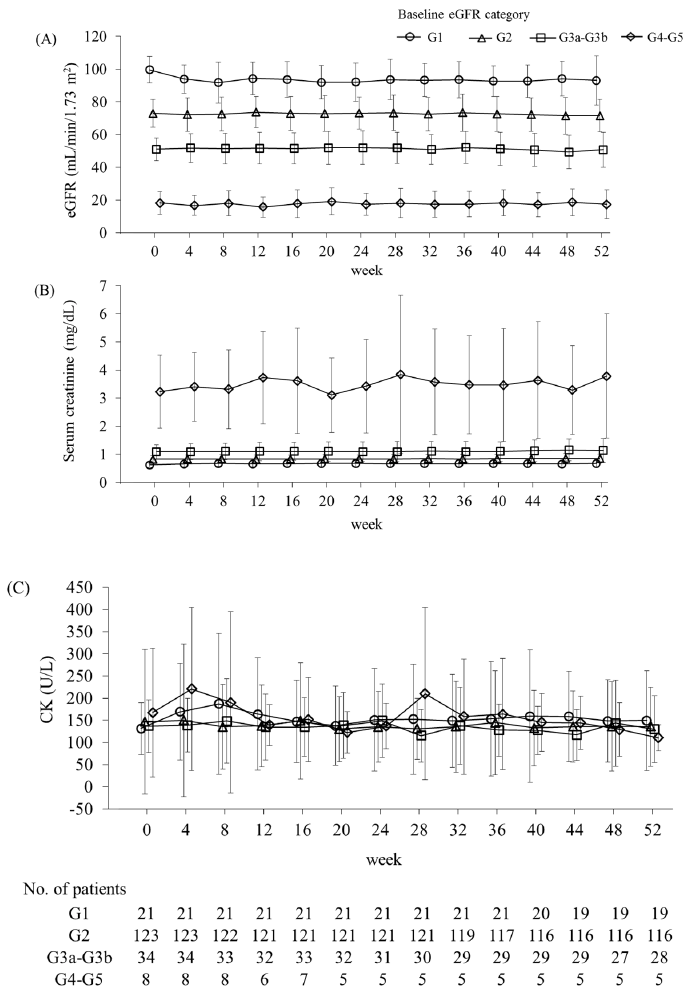
Figure 5. Time course of the levels of eGFR ( A ), serum creatinine ( B ), and CK ( C ) by baseline eGFR category. Baseline eGFR categories are as follows: G1, eGFR ≥ 90 mL/min/1.73 m 2 ; G2, eGFR ≥ 60 and <90 mL/min/1.73 m 2 ; G3a–G3b, eGFR ≥ 30 and <60 mL/min/1.73 m 2 ; and G4–G5, eGFR <30 mL/min/1.73 m 2 . Data are presented as means ± SD. eGFR, estimated glomerular filtration rate; CK, creatine kinase; SD, standard deviation.